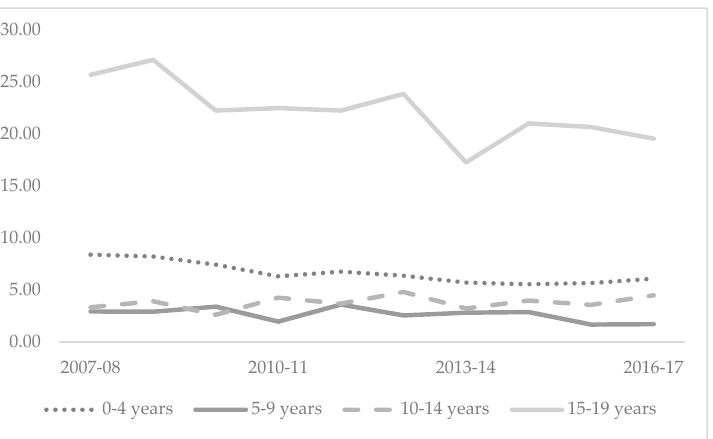
Figure 2. Crude rate per 100,000 of injury-related fatalities among children and adolescents 0–19 years, Australia 2007-08 to 2016-17.